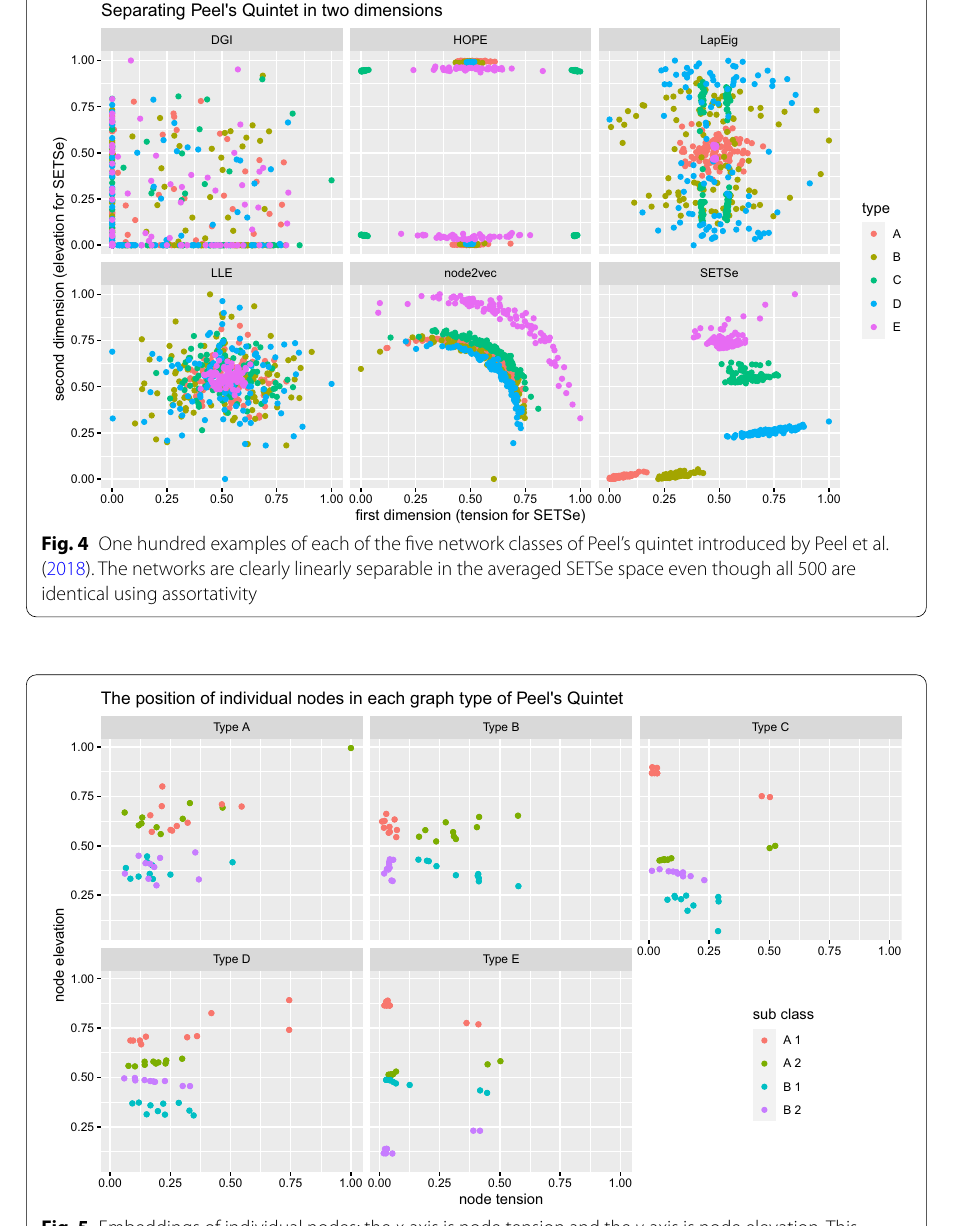
Fig. 5 Embeddings of individual nodes; the x -axis is node tension and the y -axis is node elevation. This representation reveals the hidden structure of the groups in all network types apart from type